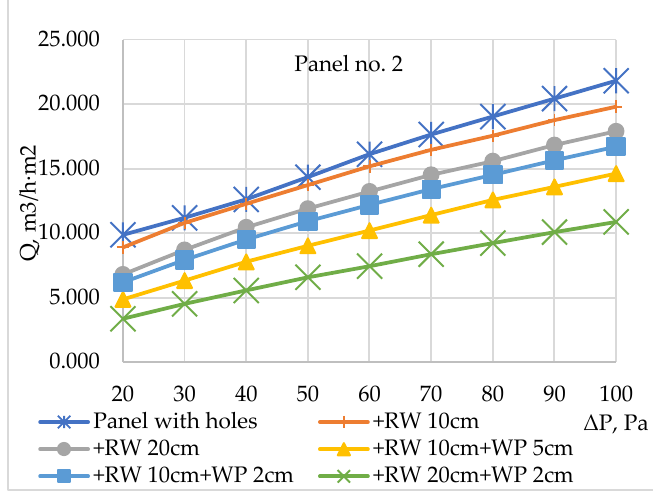
Figure 7. Panel no. 2: air permeability dependence on pressure di ff erence when various insulation variants were applied.